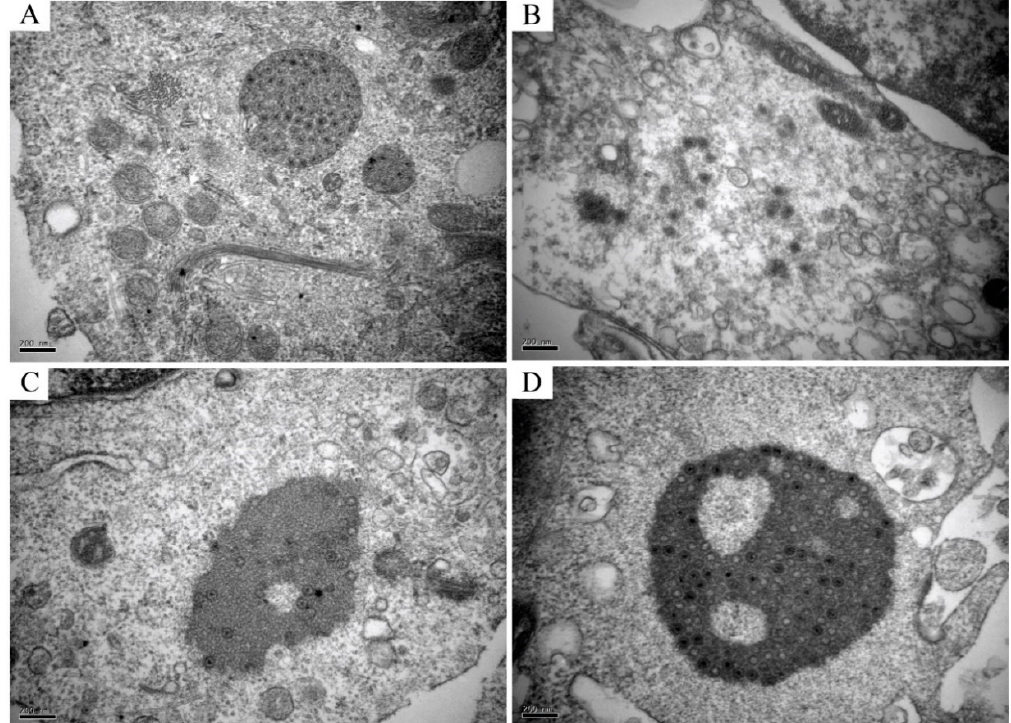
Figure 4. Several different morphogenesis of GCRV-II in CIK cells. ( A ) Mature virions arranged neatly like a lattice, with a diameter of about 70–80 nm; ( B ) Scattered virions, released in the cytoplasm, with a diameter of about 70–80 nm; ( C ) Early virus inclusion bodies are relatively dense and contain a small number of virions, which are in the process of forming; ( D ) Late VIBs, which are thick and have a large number of virions, are in the process of generating.